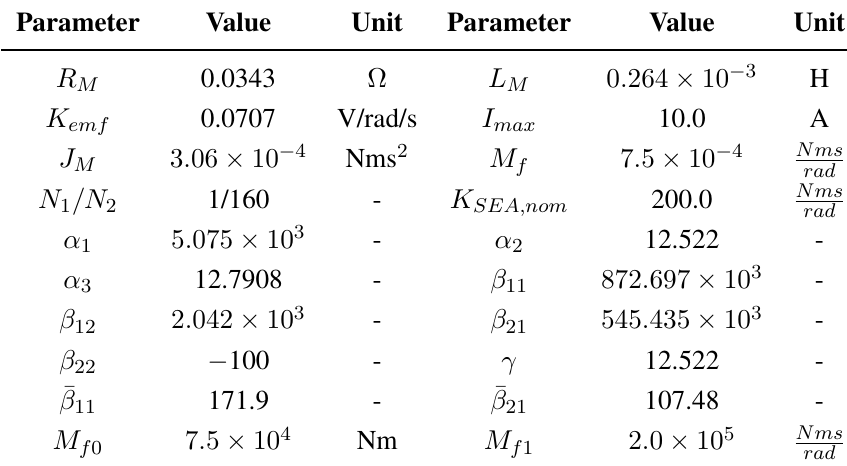
Table A1. Parameters used for all simulations.